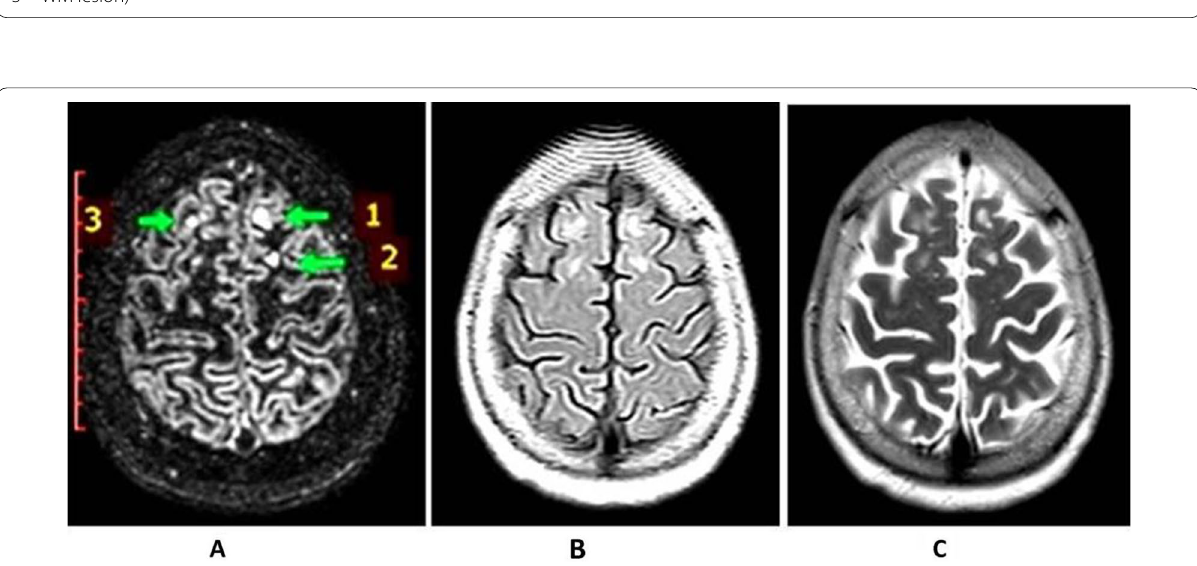
2. A – C (Axial DIR, Flair and T2 = intracortical, 2 juxtacortical and = =